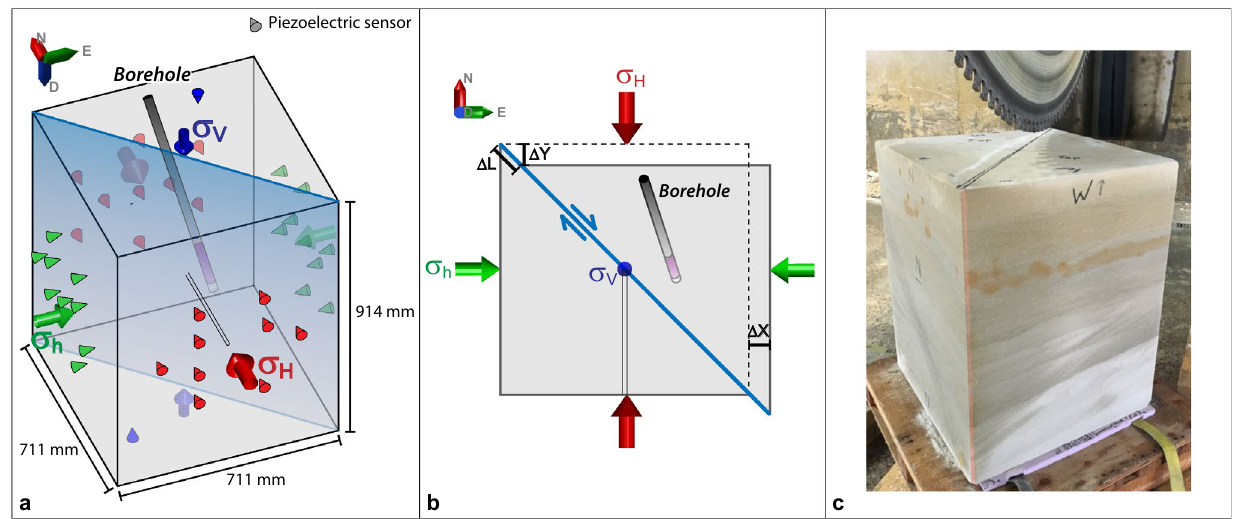
Figure 1. Picture and schematics of the experimental setup. ( a ) Schematic 3D-view of the assembled block showing the positions of the 38 piezoelectric sensors (red, green and blue cones), the main injection borehole, a secondary injection borehole reaching into the interface and the saw cut interface (blue plane). Green, red, and blue arrows show applied stresses. ( b ) Plan-view of the block indicating measured displacements ∆x and ∆y and calculated interface displacement ∆L. The open section of the main injection borehole is indicated with magenta shading. ( c ) Picture of the Castlegate Sandstone block just before cutting the